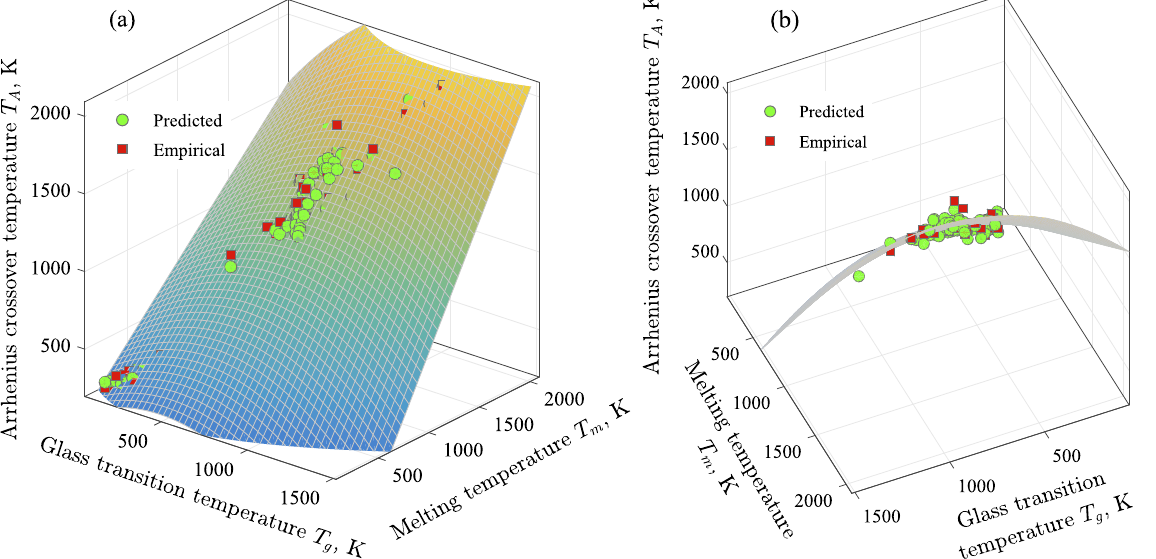
Figure 4. ( a ) Correspondence between the Arrhenius crossover temperature ( T A ), the melting tem- perature ( T m ) and the glass transition temperature ( T g ). Circle and square markers denote predicted and empirical data, respectively. These data are compared with the results of Equation (11), which are presented as a curved surface. ( b ) This figure is from an another foreshortening, which allows one to consider the curved